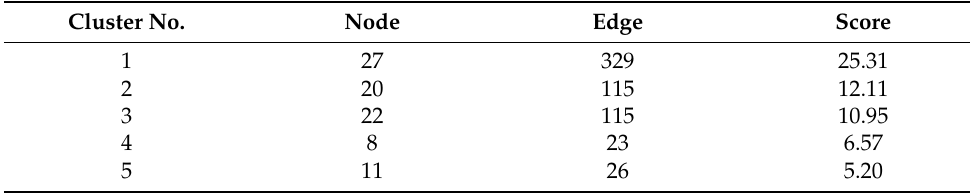
Table 2. The top 10 hub genes ranked by the connection degree.